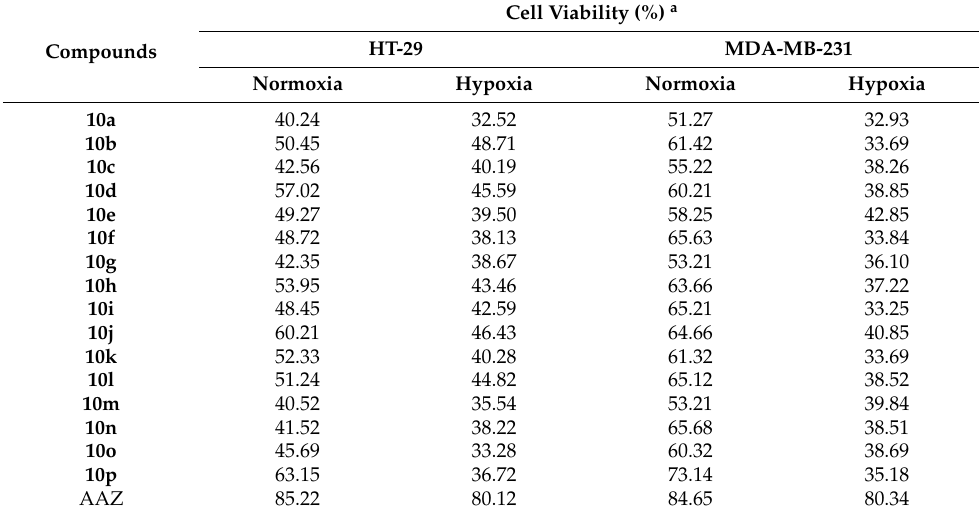
Table 4. Effects of target compounds on two cancer cells viabilities at 100 µ M